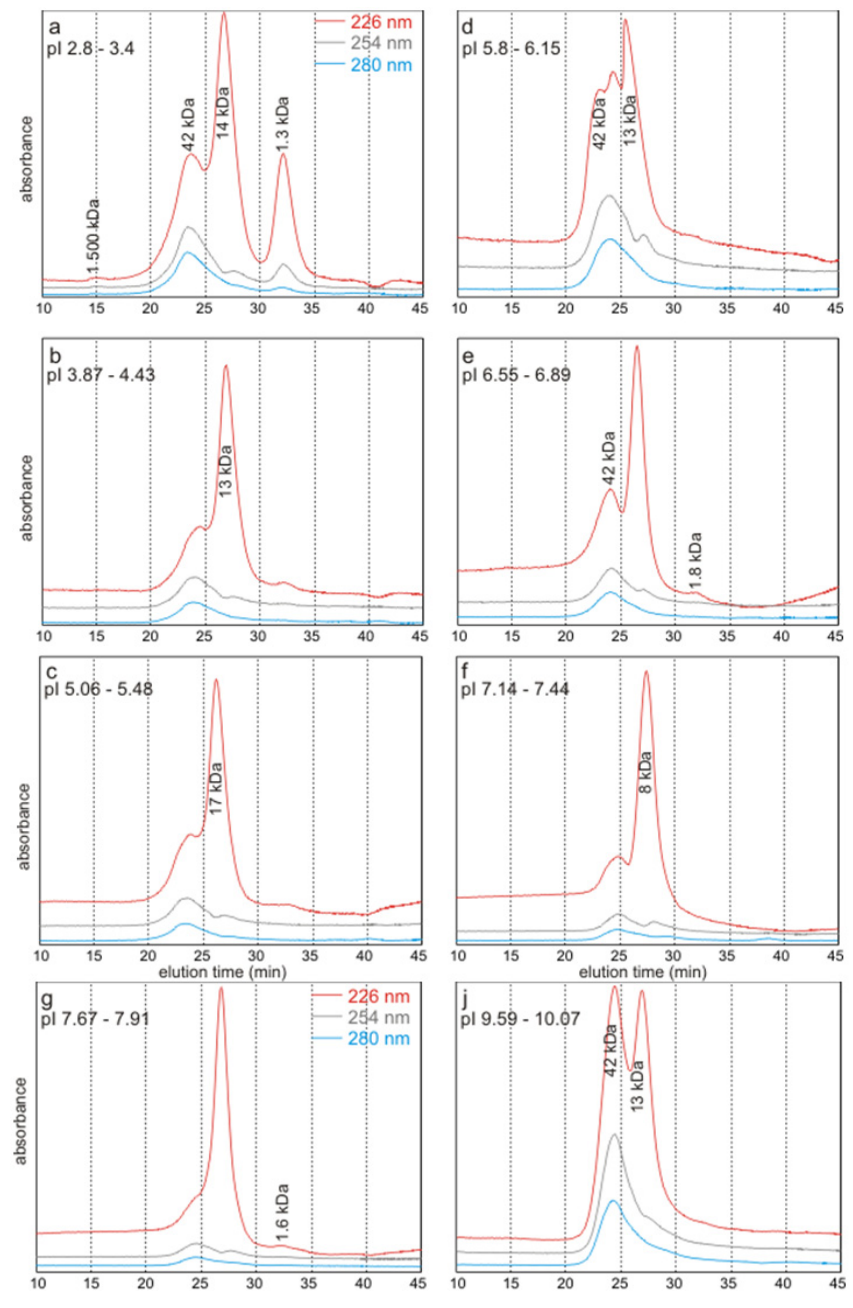
Figure 4. HPLC profiles of SOM after the pI fractionation with preparative electrophoreses ( a – i ); l: standard proteins. Molecular weights differ in every fraction. However the asymmetry of the peaks shows that they are composed of several